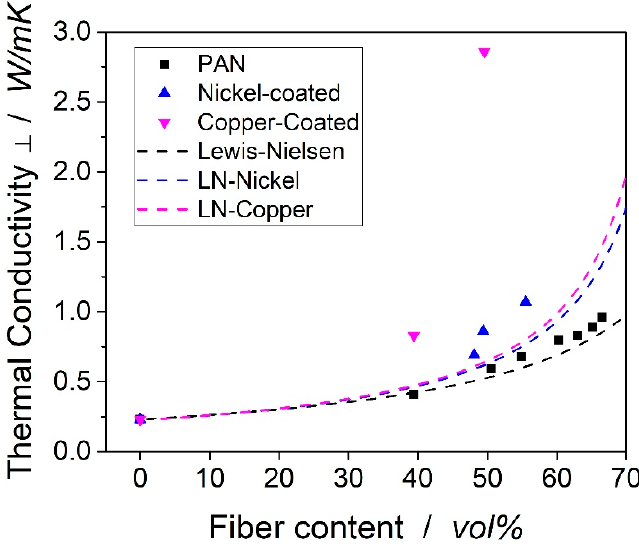
Figure 8. Experimental data versus analytical data from the presented model.